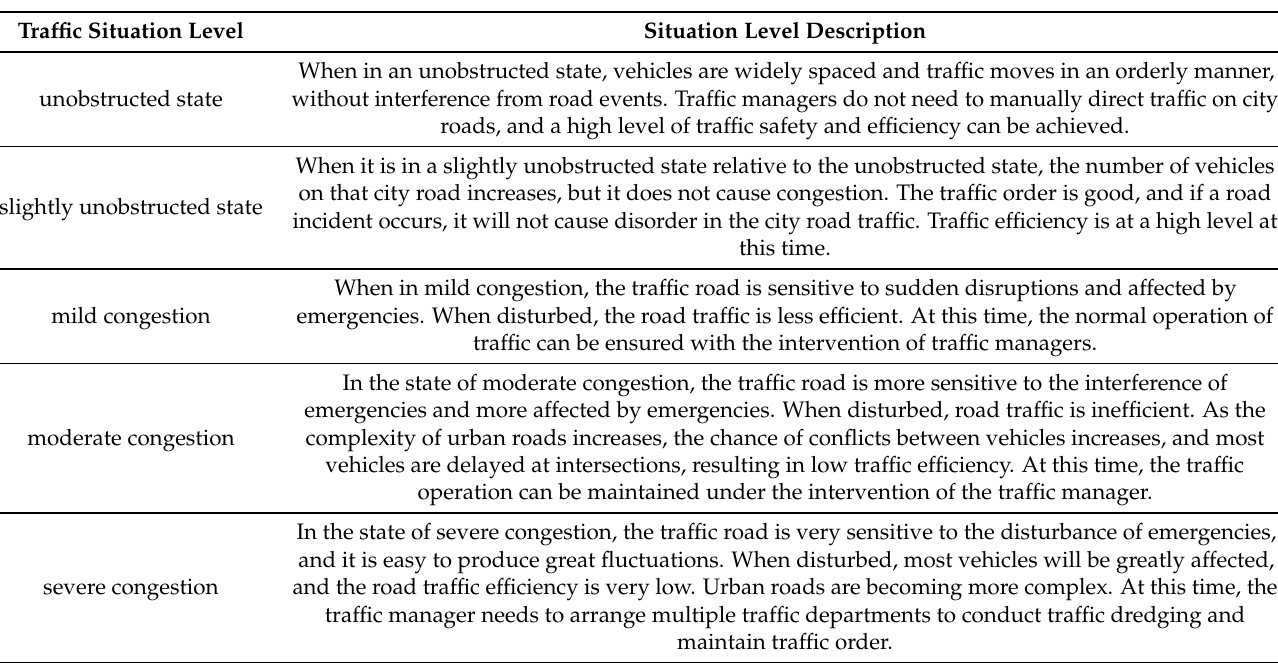
Table 1. Road traffic situation level